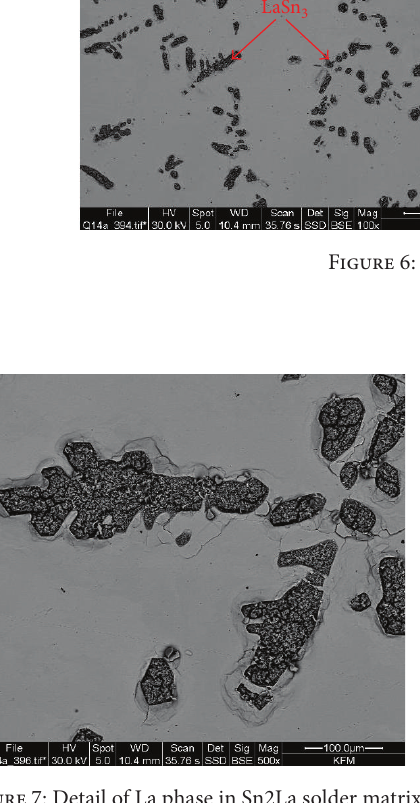
Figure 7: Detail of La phase in Sn2La solder matrix.